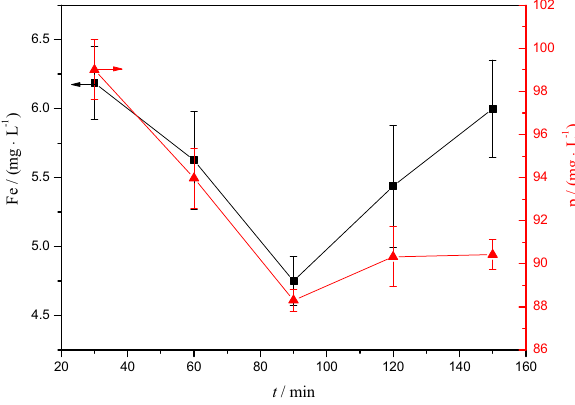
Figure 3: Content of iron and phosphorus in the fi ltrate at di ff erent reaction time. n P/ n Fe = 6.0, T = 333 K, pH =